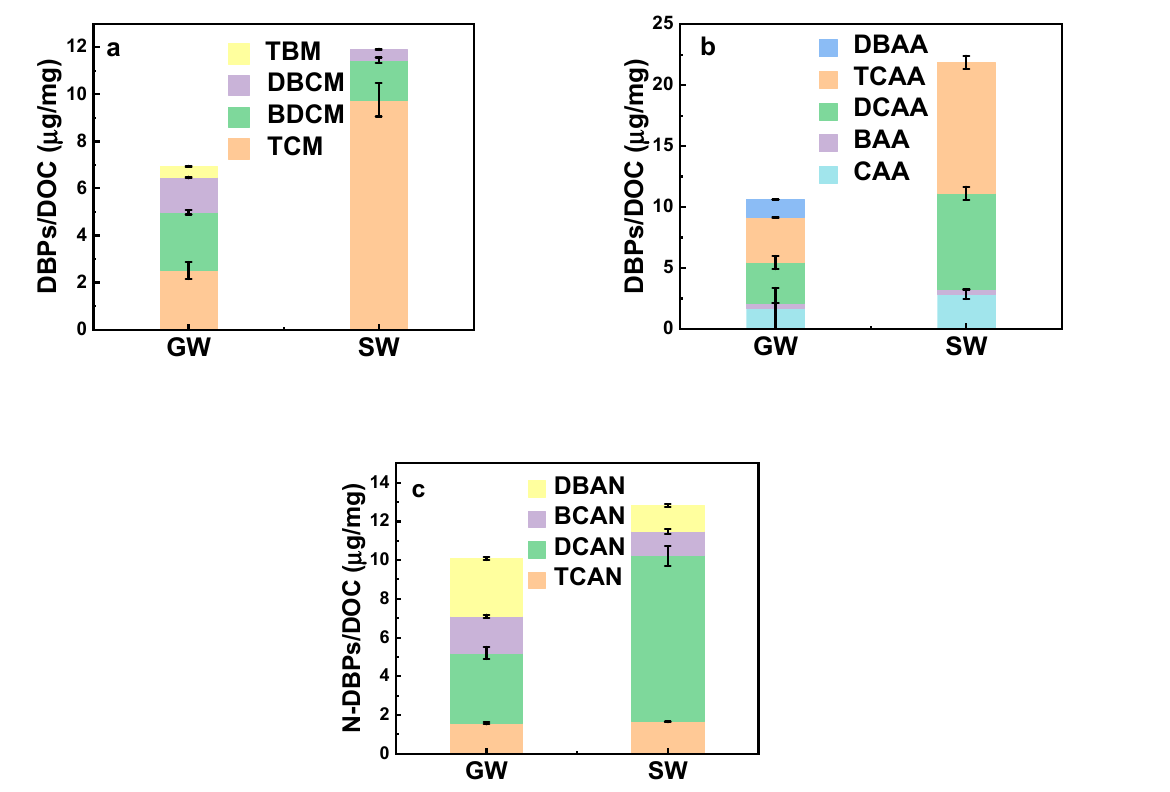
Figure 4. The DBPFP of the GW and SW by chlorine disinfection: ( a ) THMs; ( b ) HAAs; ( c ) HANs.